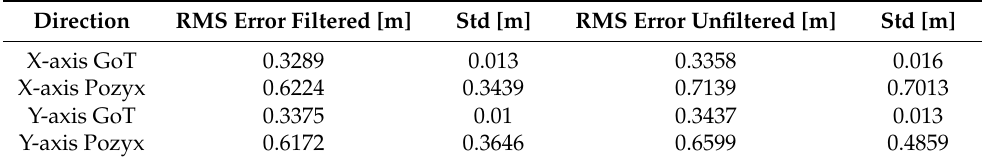
Table 3. Filtered and unfiltered RMS errors for X- and Y-directions.